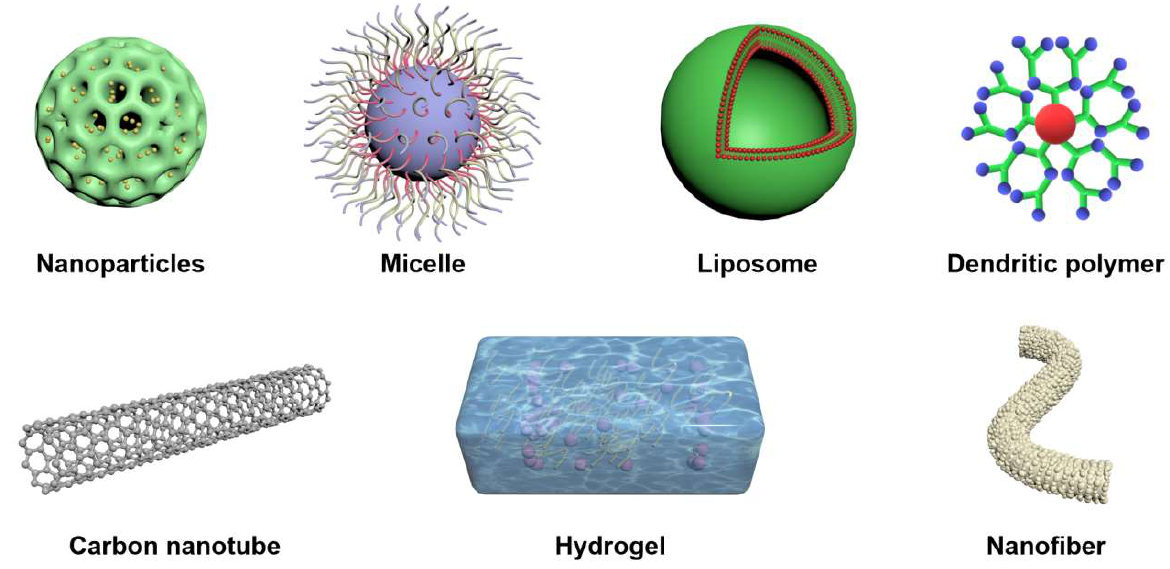
Figure 10. Herbal nanomedicine system.